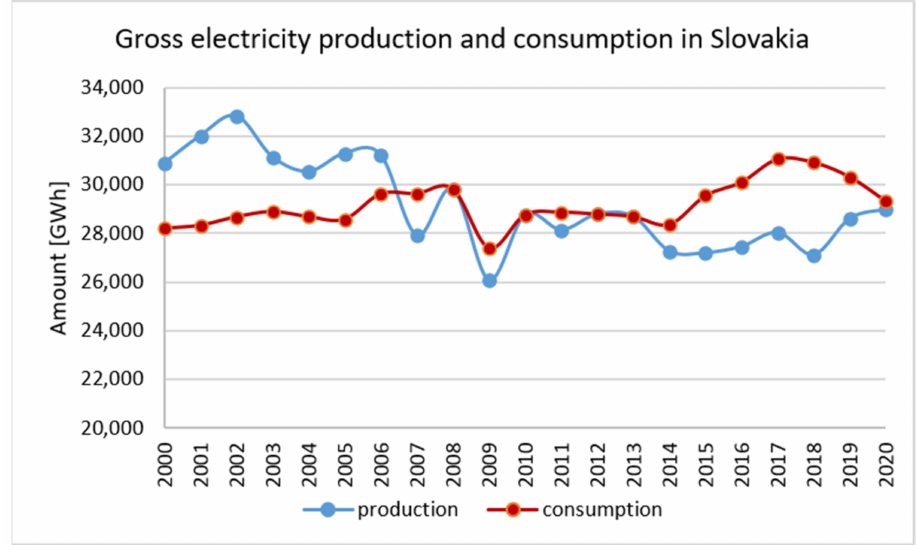
Figure 2. Gross electricity production and consumption in Slovakia